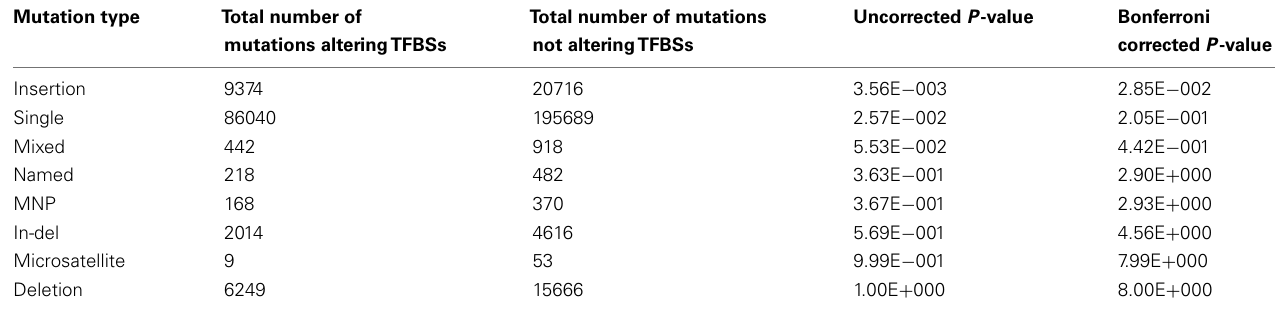
Table 1 | Enrichment of mutation types found altering predictedTFBSs.